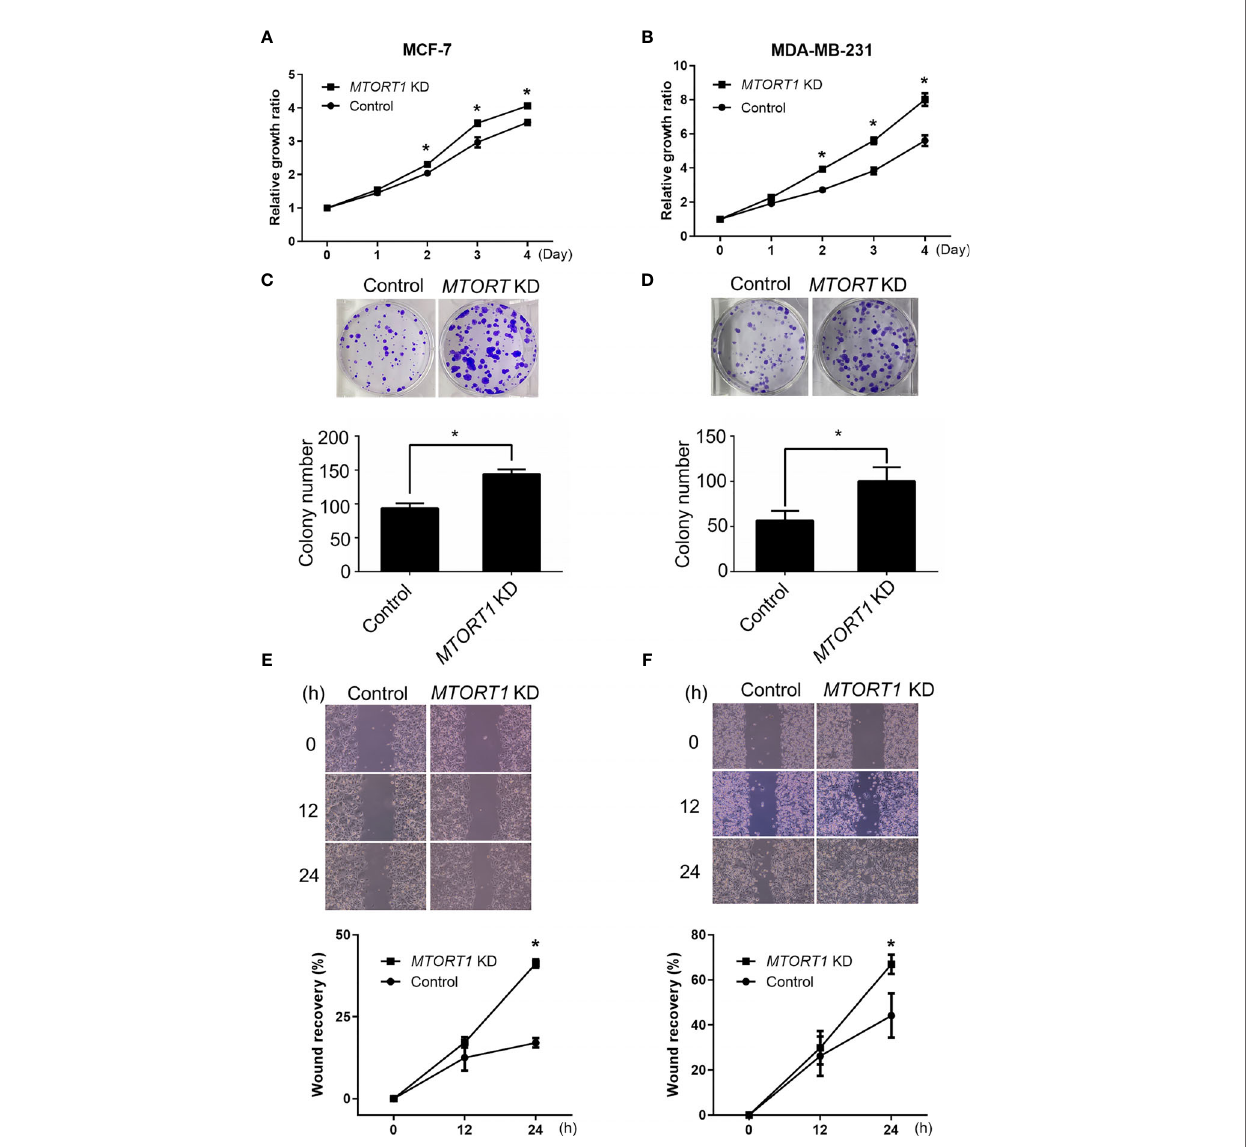
FIGURE 4 | Knockdown of MTORT1 enhances cell proliferation, migration, and invasion. (A, B) Cell proliferation using MTT assays. Cell growth was measured in MCF-7 (A) and MDA-MB-231 (B) cells treated with siRNA against MTORT1 . The growth ratio was normalized to day zero. (C, D) Colony formation assay. Top: Representative images were taken of MCF-7 (C) and MDA-MB-231 (D) cells. Bottom: Quanti fi cation of colony counts. Colonies with cell numbers greater than fi fty were counted. (E, F) Wound healing assay. Top: Representative images were taken of MCF-7 (E) and MDA-MB-231 (F) cells. Bottom: Quanti fi cation of wound recovery. The gap area was imaged at 0, 12, and 24 h. The percentage of wound recovery was compared to the wound area at 0 h. The results are means ± SDs (n = 3). * P <